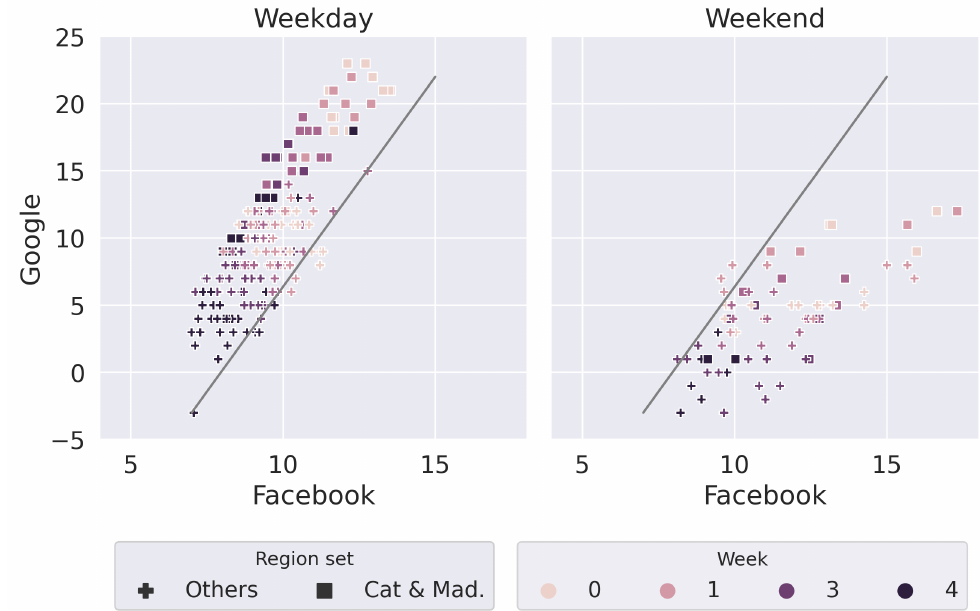
Figure 7. Mobility values from Monday to Friday ( left plot ) and from Saturday to Sunday ( right plot ). A color gradient indicates the week number (from 25 March to 27 June), and the shape of the marker indicates the region set (Crosses: Asturias, Navarre, La Rioja, Region of Murcia, Extremadura and Galicia. Squares: Catalonia and Madrid). The grey diagonal line is the same on both plots, used for the purpose of visual